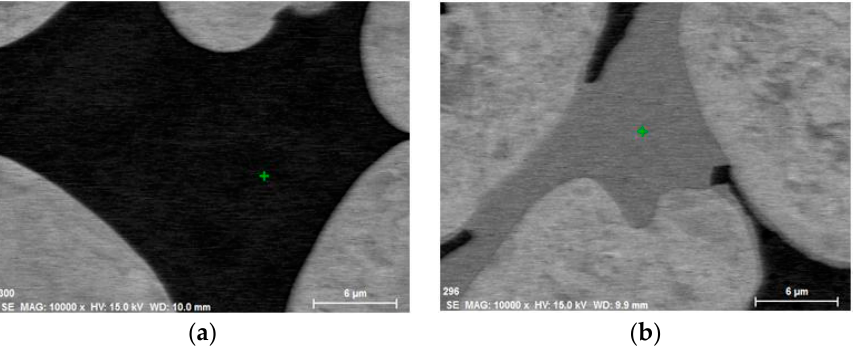
Figure 5. Illustration of places where EDS analyses were carried out: ( a ) matrix; ( b ) W-rich phase. The point where the chemical composition was analysed is marked with a green cross. Table 5. The results of the chemical analysis.